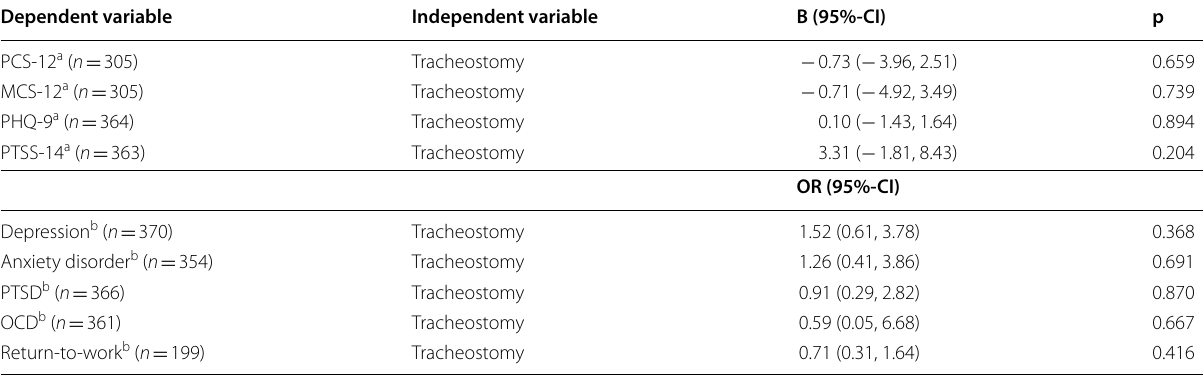
Table 4 Multivariable linear and logistic regression models on HRQoL, psychiatric symptoms and return-to-work after 12 months (adjusted for age, sex, BMI, severity of ARDS, SOFA score, SAPS-II and length of ICU